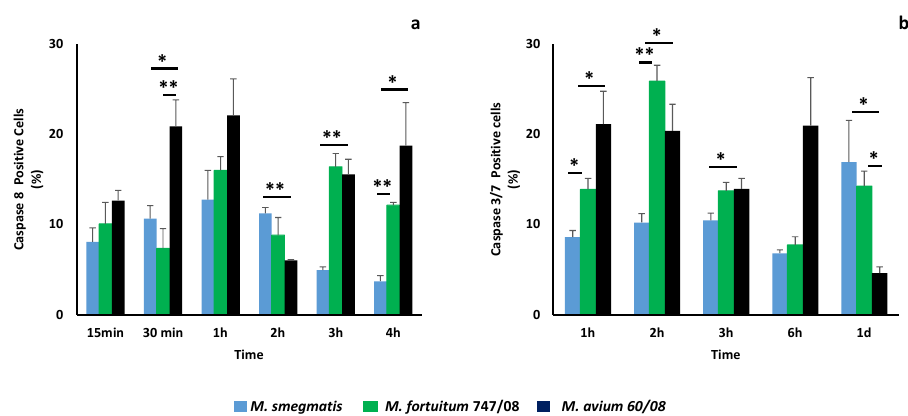
Figure 4. Apoptosis induction during nontuberculous mycobacteria infection. Apoptosis induction mediated by caspase 8 ( a ) and caspase 3 / 7 ( b ) in macrophages infected with M. smegmatis , M. fortuitum 747 / 08 or M. avium 60 / 08 was evaluated. (* p < 0.05; ** p <